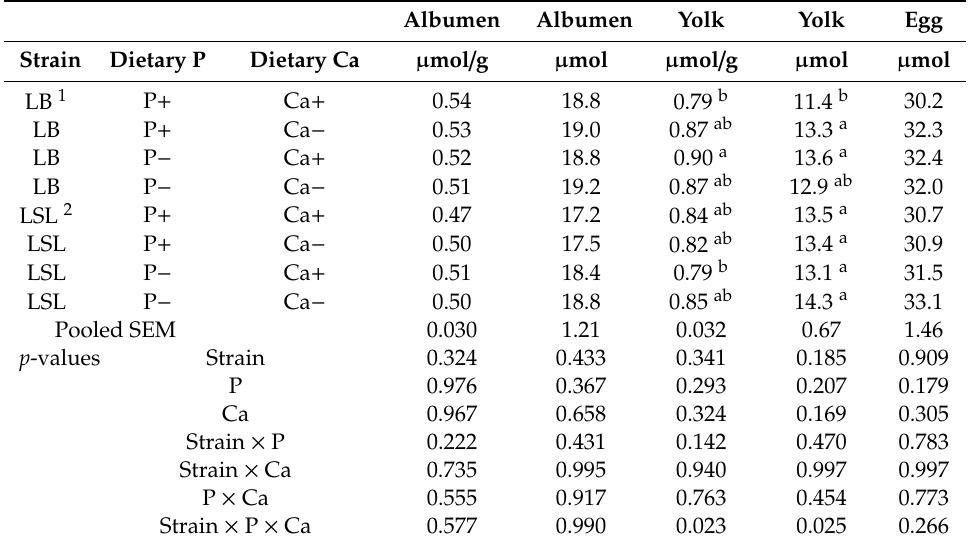
Table 9. E ff ect of strain, P, and Ca on concentrations and contents of myo -inositol in the albumen, yolk, and egg (without shell) of laying hens aged 31